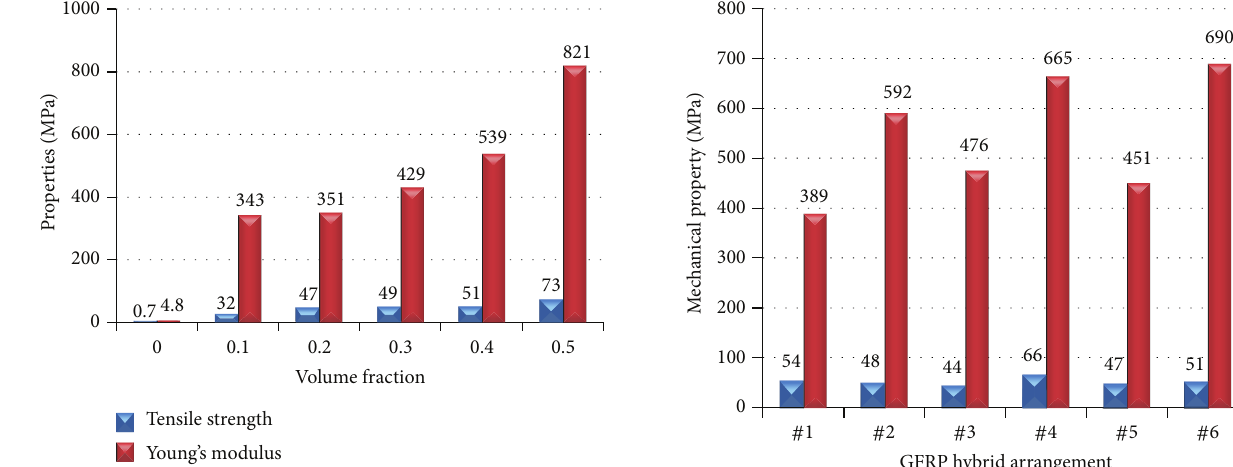
Figure 4: Mechanical properties of hybrid GFRP varying fibre volume fraction.